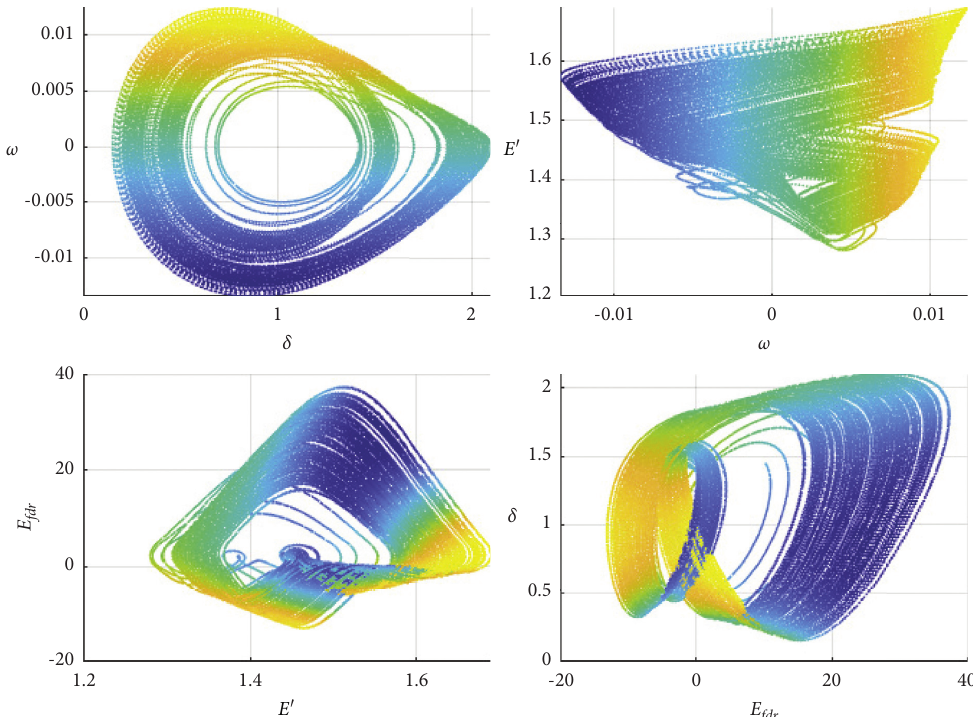
Figure 3: Phase portraits of chaotic fractional-order four-dimensional power system (10) for different projections.